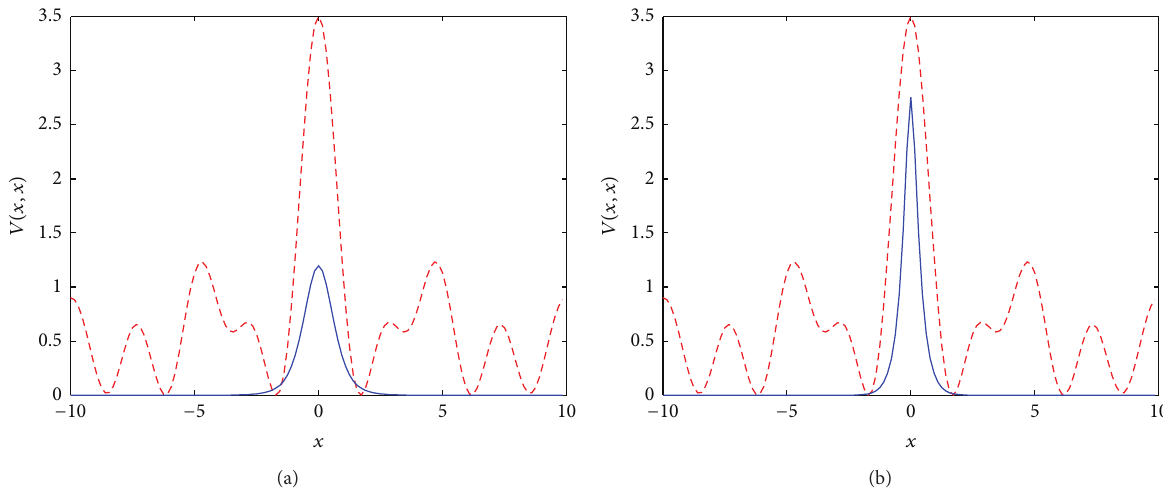
Figure10:Thelatticesolitonprofilesfortheself-focusingcubicandtheself-focusingquinticmodel.(a)Crosssectionalong 𝑥 -axisofthelattice solitons corresponding to the first renormalization factor (solid line) superimposed on the underlying Penrose potential (dashed line). (b) Cross section along 𝑥 -axis of the lattice solitons corresponding to the first renormalization factor (solid line) superimposed on the underlying Penrose potential (dashed line).